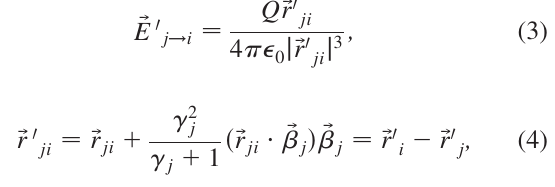
FIG. 2. (Color) The further evolution of the bunch in Fig. 1 is shown 3 ps later in the longitudinal phase space with the calculations performed in the mean rest frame. Part (a) displays the longitudinal phase space of the bunch transformed to the laboratory frame using Eqs. (2). The slice energy spread yields significantly smaller values than the total energy spread of the bunch. This fact also leads to a gap in the phase space. The reason for this property can be seen in (b), where the longitudinal phase space is drawn with the longitudinal normalized velocity color coded in the mean rest frame. The plasma boundary leads to an asymmetric particle distribution in the mean rest frame. The instantaneous onset of the Coulomb interaction in the mean rest frame would lead to a symmetric particle distribution as shown in (c) and (d) in a direct comparison after 0.7 ps of